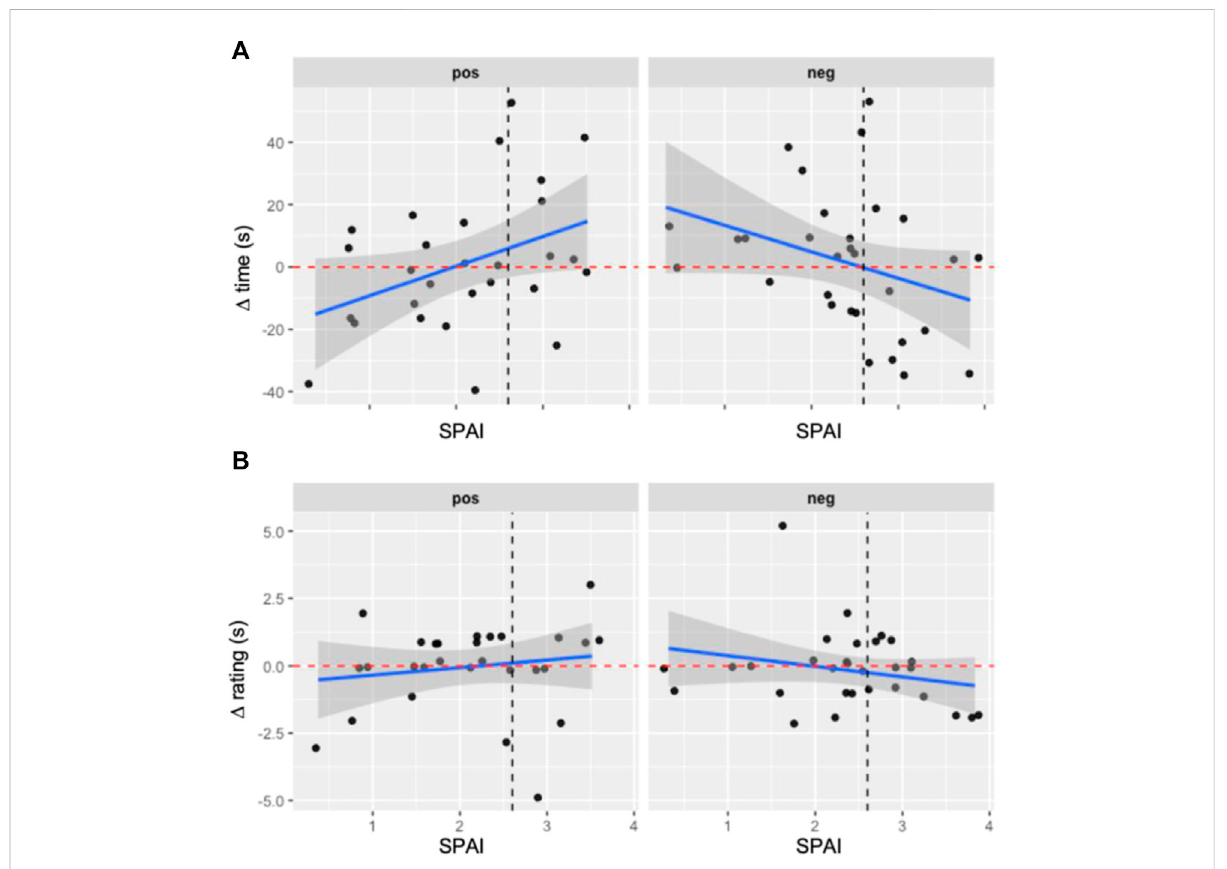
Results of explorative correlational analyses between individual differences in trait social anxiety (SPAI) and variations in behavioral ( Δ time) and verbal ( Δ rating) measures indicating the SCPP/SCPA effect. The SPAI scores are depicted on the x -axis, while (A) Δ time (time spent in the room in which the agent was presented during conditioning minus the time spent in this room during habituation) and (B) Δ rating (preference rating of the room in which the agent was presented during conditioning minus the rating of this room during habituation). A happy-looking agent was presented to half of the participants (left); the other group encountered an angry-looking agent. All graphs depict social anxiety (SPAI score) on the horizontal axis and change in place preference on the vertical axis. Blue line: approximated regression slope. Gray area: estimated error of the linear